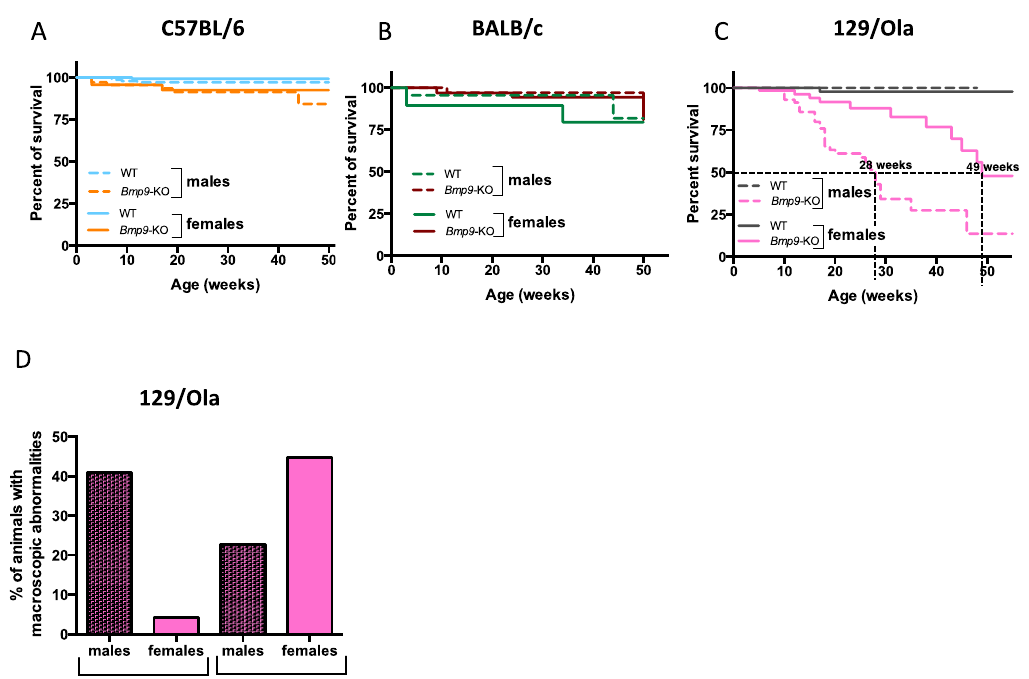
Figure 1. Survival curves of Bmp9 -KO mice of three genetic backgrounds. ( A ) Survival in C57BL / 6 background (wild-type (WT) males n = 154, WT females n = 168, Bmp9 -KO males n = 63, Bmp9 -KO females n = 43). ( B ) Survival in BALB / c background (WT males n = 42, WT females n = 49, Bmp9 -KO males n = 44, Bmp9 -KO females n = 75). ( C ) Survival in 129 / Ola background (WT males n = 62, WT females n = 61, Bmp9 -KO males n = 44, Bmp9 -KO females n = 59). ( D ) Macroscopic alterations of kidneys and the liver revealed at autopsy in 129 / Ola Bmp9 -KO mice before 50 weeks of age. Results are expressed in terms of percentage of total autopsied animals (females n = 51; males n = 61).